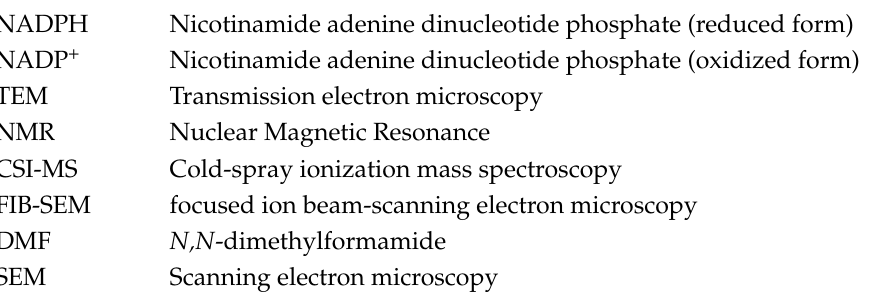
Figure S1, S3, S5 and S7: 1 H NMR spectra of the precursor compounds of Dyes 3 , 4 , 5 and 6 ; Figure S2, S4, S6 and S8: 13 C NMR spectra of the precursor compounds of Dyes 3 , 4 , 5 and 6 ; Figure S9: CSI-MS spectra of Dyes 1 – 6 ; Figure S10: Cyclic voltammograms of Dyes 1 – 6 ; Figure S11: Particle size distribution of KTa(Zr)O 3 measured using a laser diffraction particle size analyzer; Figure S12: TEM image of KTa(Zr)O 3 ; Figure S13: UV-vis spectrum of KTa(Zr)O 3 ; Figure S14: Time course of water splitting over Pt-loaded KTa(Zr)O 3 modified with Dyes 1 – 6 ; Figure S15: UV-vis absorption spectra of Dye 2 present on KTa(Zr)O 3 before and after the photocatalytic reaction; Figure S16: Gas formation rates of water splitting on Pt/Dye 2/KTa(Zr)O 3 ; Figure S17: XRD pattern of KTa(Zr)O 3 ; Figure S18: Schematic image of a closed-circulation type glass reactor; Figure S19: Spectrum of the Xe lamp used in this